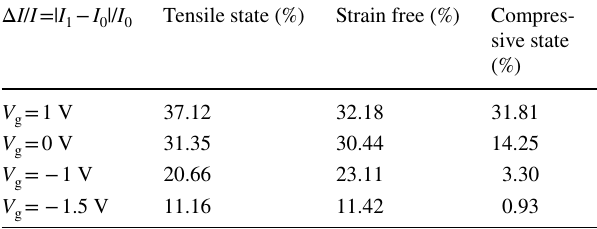
Table 3 The relative change of saturation drain current